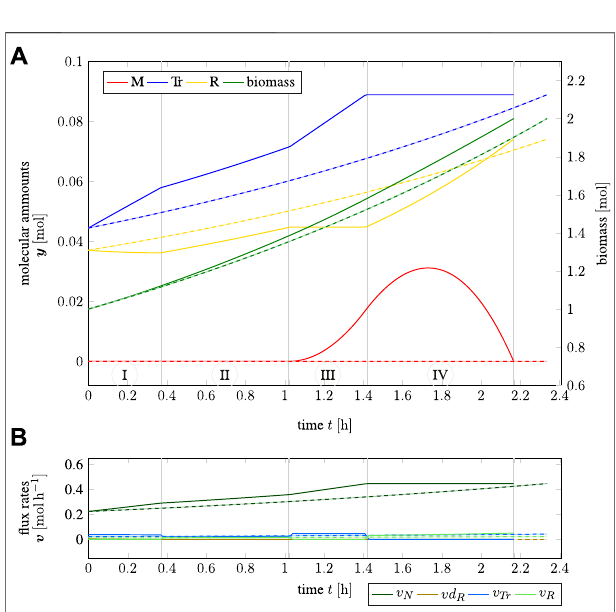
FIGURE 3 | Cell cycle of an “ optimistic ” cell; (A) amounts and biomass as a function of time, (B) fl ux rates as a function of time; solid lines indicate the solution of TOA, dashed lines indicate iterative RBA (exponential growth) with the same “ optimistic ” initial values.